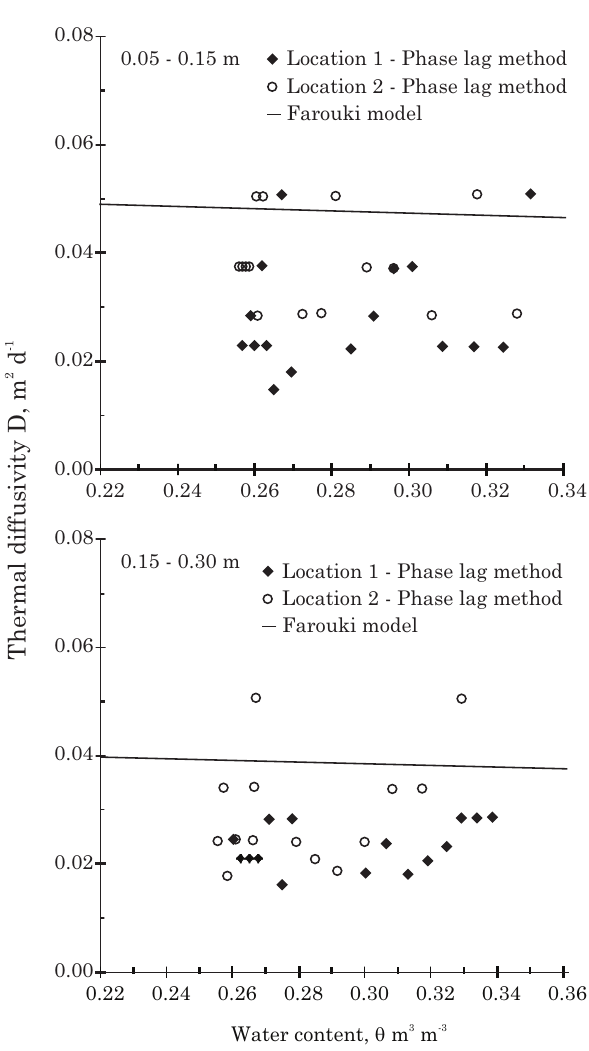
Figure 3. Thermal diffusivity D determined by the phase lag method (Equation 14) versus observed water content θθθθθ for both Locations and both depth intervals. The solid line represents model predictions (Equation 16 divided by Equation